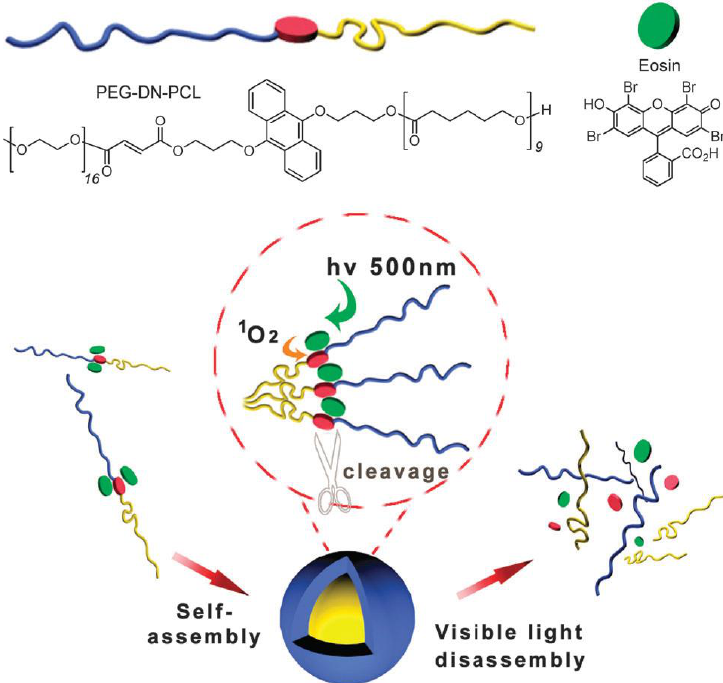
Figure 8. Schematic representation of a poly(ethylene glycol)- block -poly(caprolactone) amphiphilic block copolymer featuring a dialkoxyanthracene block junction, its self-assembly and visible light-triggered disassembly via photo-cleavage of the block junction. Reproduced from Ref. [160] with permission from the Royal Society of Chemistry.